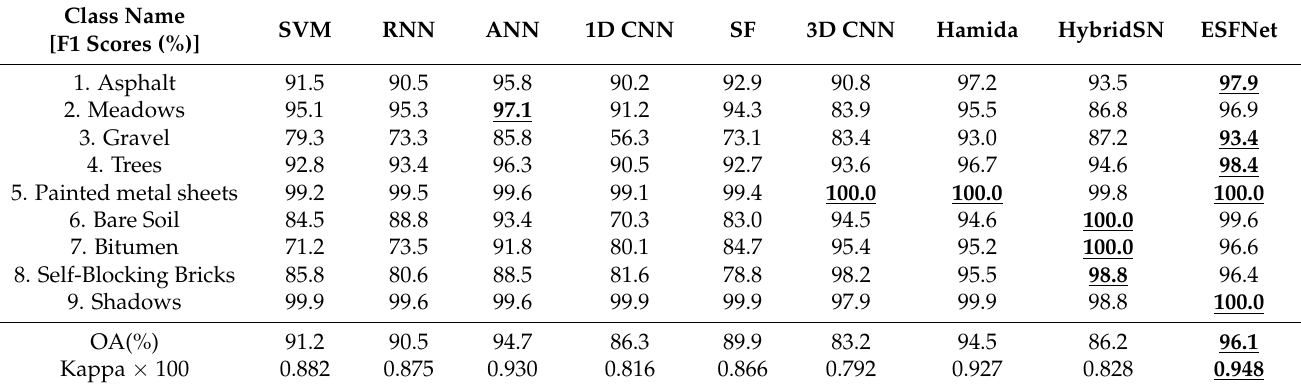
Table 6. Classification results of nine models on the Pavia University